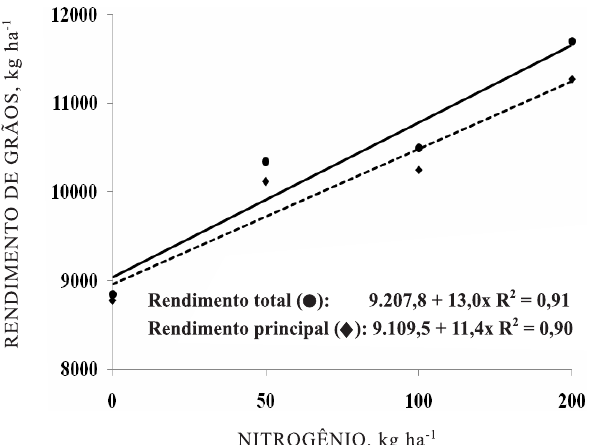
Figura 1. Rendimento de grãos, total e do colmo principal, em função de doses de nitrogênio aplicadas em cobertura. Lages, SC, safra 2008/ 2009. Média de três épocas de aplicação.